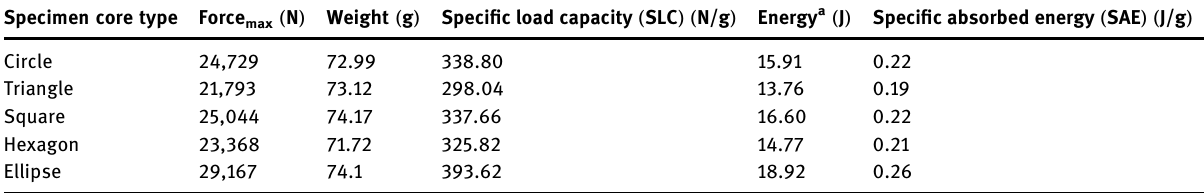
Table 5: Simulation results of the aluminium alloy perforated sheet metal ( staggered arrangement ) obtained from fi nite element analyses